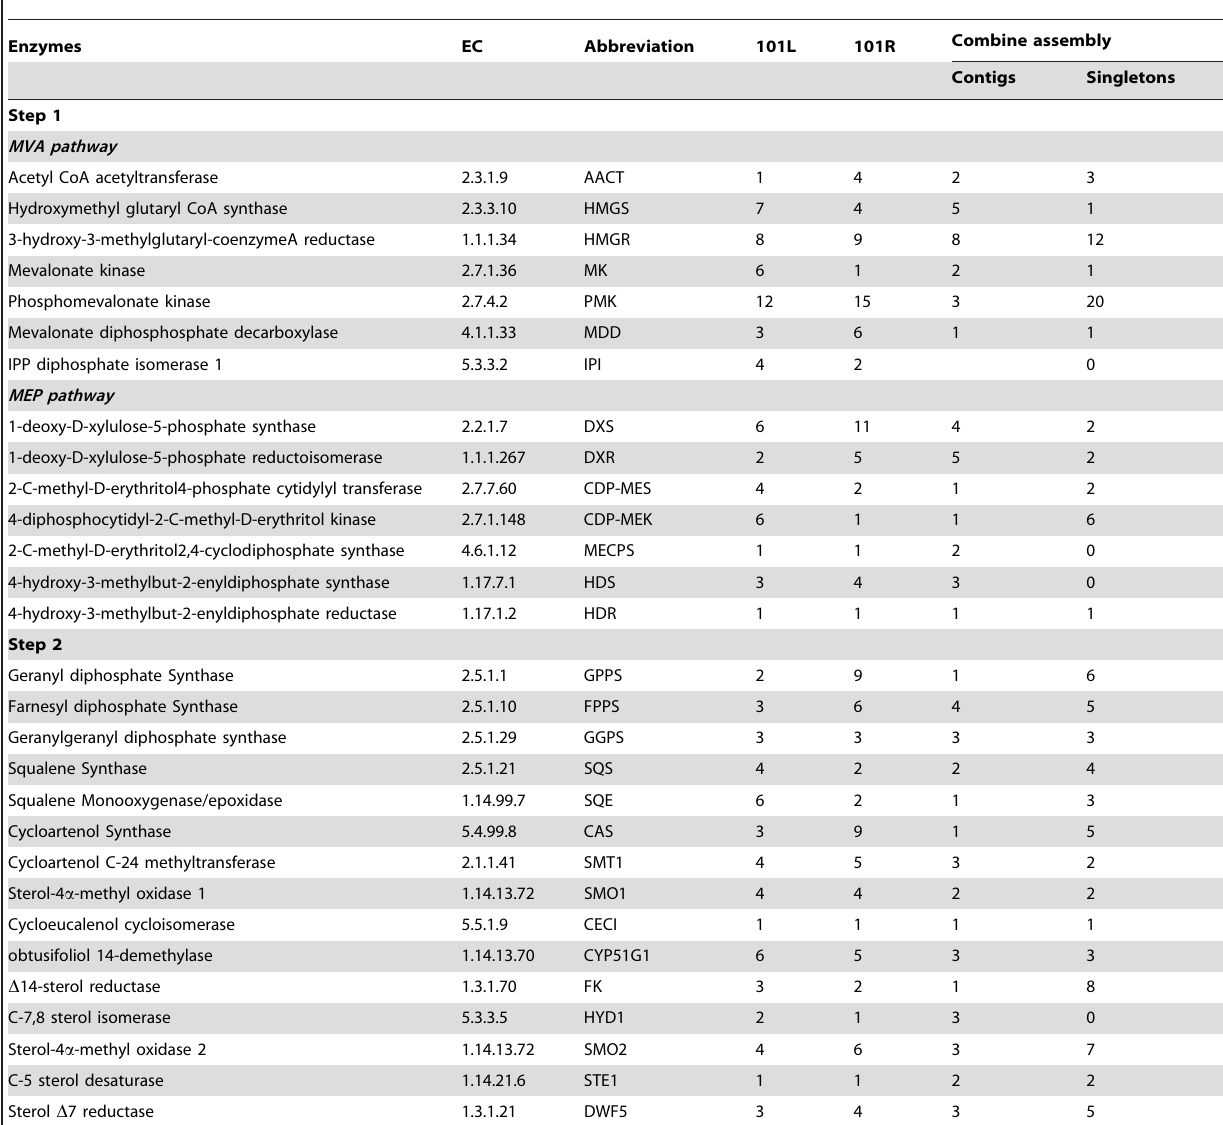
Table 4. Numbers of unigenes encoding enzymes involved in triterpenoid biosynthesis.